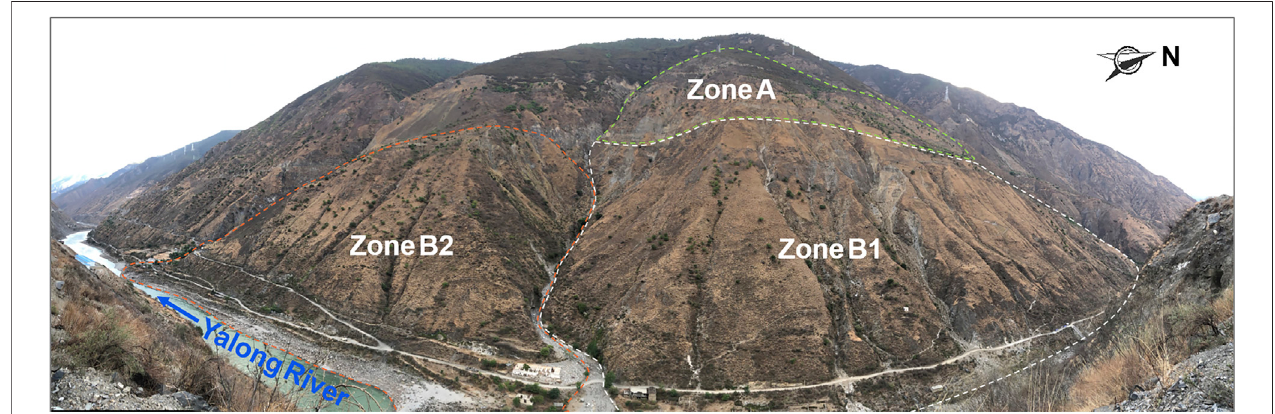
FIGURE 1 | The Zhoujia